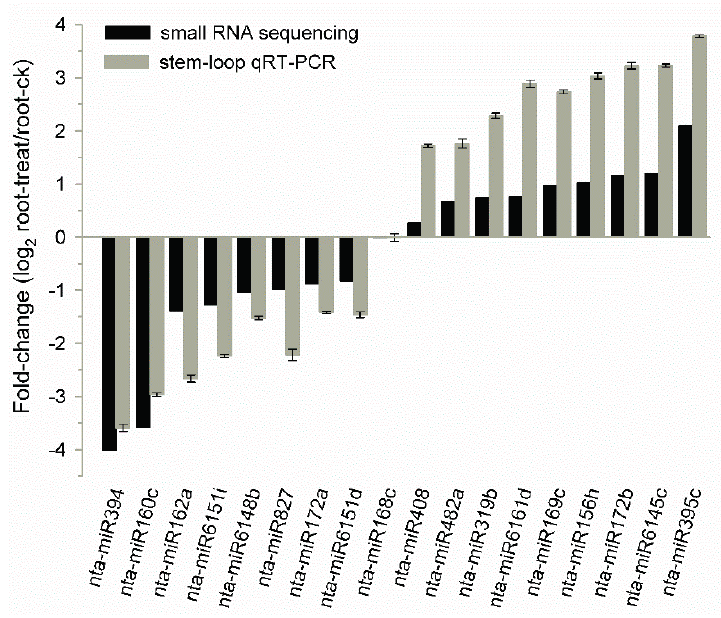
Figure 5. Expression of 18 miRNAs randomly selected in control and drought-treated roots of tobacco. The black bars represent the fold change (log2) in control library relative to drought-treated library detected by Solexa small RNA sequencing, while the gray bars represent the fold change (log2) in control roots relative to drought-treated roots detected by stem-loop qRT-PCR (normalized to 5S rRNA; n =